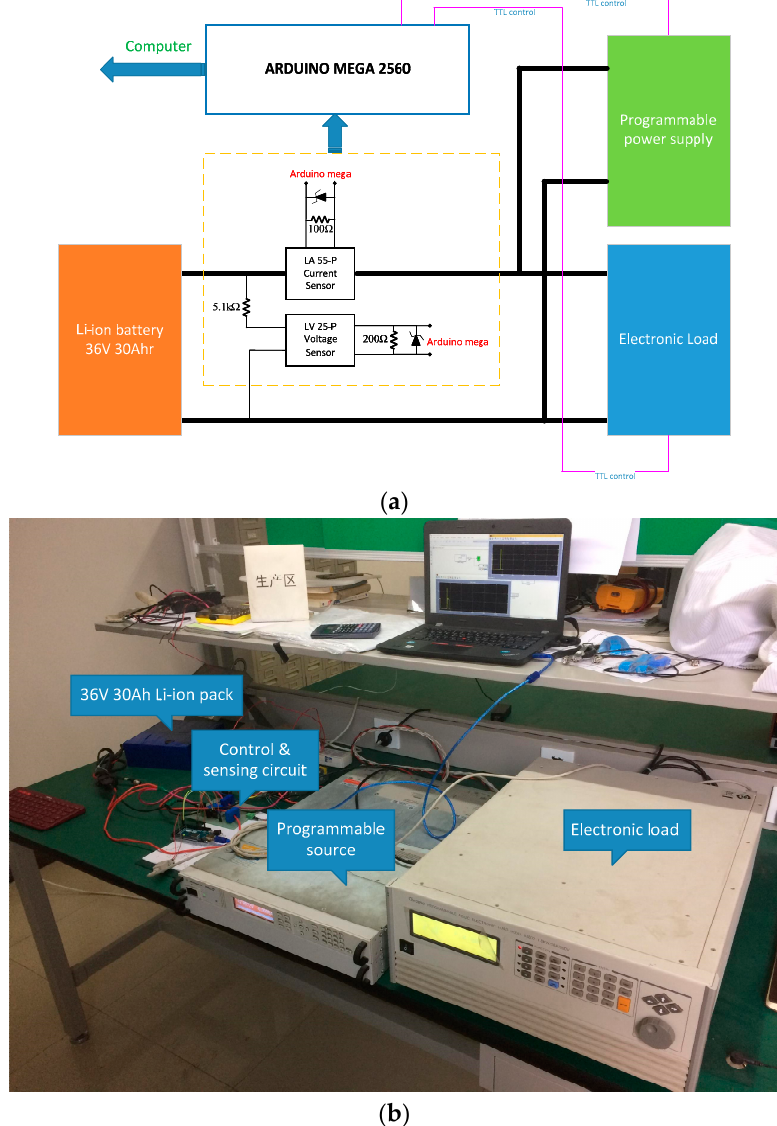
Figure 3. ( a ) Experiment layout for testing the battery; ( b ) Experiment test bench of Li-ion battery.